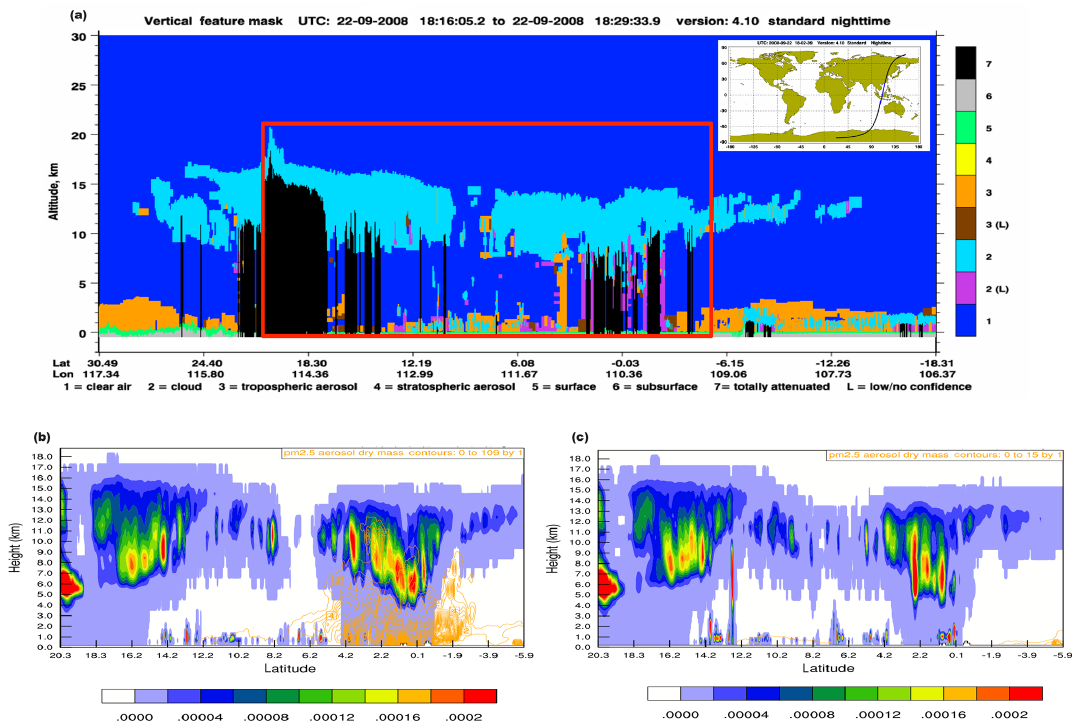
Figure 6. (a) The vertical structure of cloud retrieved from the Cloud-Aerosol Lidar and Infrared Pathfinder Satellite Observation (CALIPSO) on 22 September 2008. (b–c) The sum of simulated hydrometeor mixing ratio (shaded; kgkg − 1 ) and PM 2 . 5 concentration (contour; µgm − 3 ) in FFBB and FF, respectively. The profile domains of (b) and (c) correspond to the red rectangle in (a) .